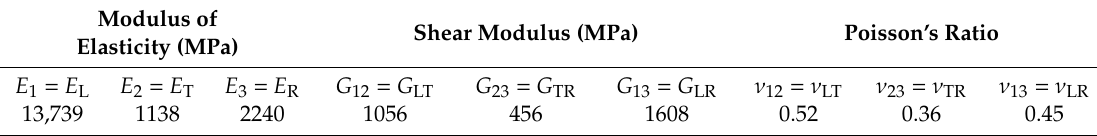
Table 2. Elastic properties for beech wood [31], taken for shear factor